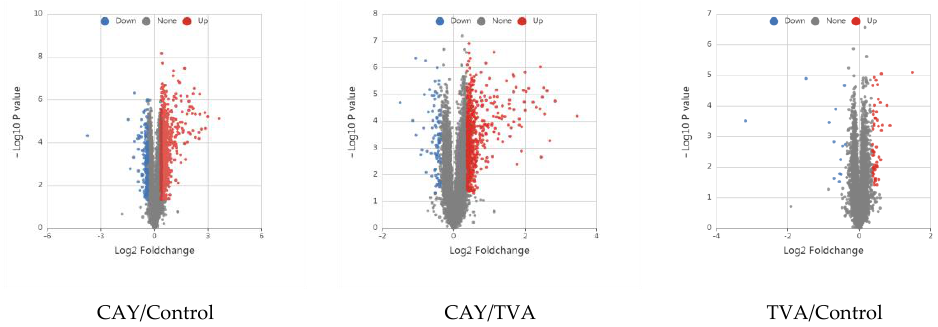
Figure 3. Volcanic map of differentially expressed proteins in MAC-T cells under different incubation conditions. The horizontal coordinate indicates the fold change (log2 transformation), while the vertical coordinate indicates the p -values (log10 transformation). Red dots indicate upregulation and blue dots indicate downregulation.